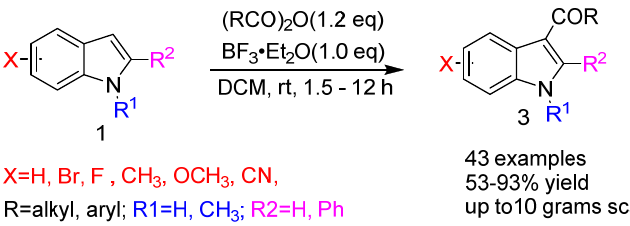
Figure 1. Bioactive products containing acylindole.